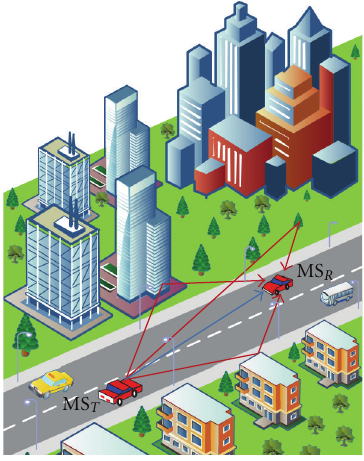
Figure 1: A typical propagation scenario along a straight street in urban